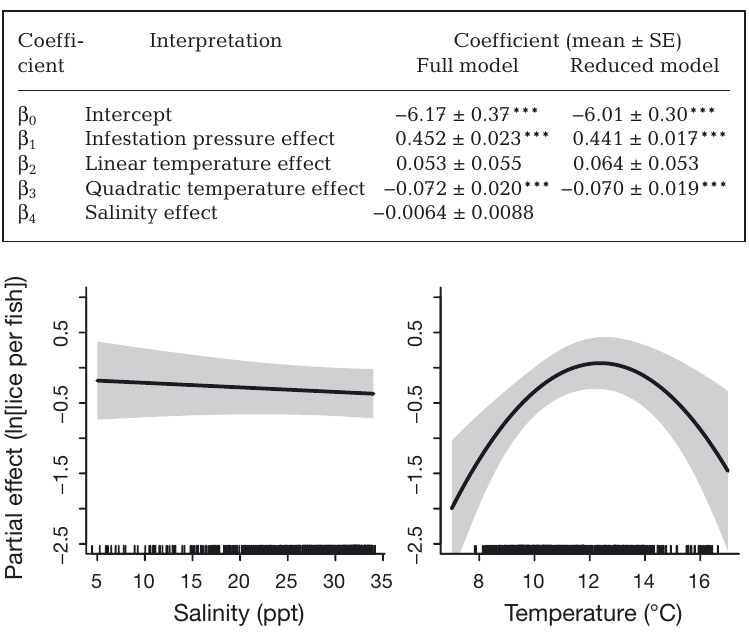
Fig. 6. Estimated additive effects of salinity and temperature on ln(lice per fish). The figure shows partial effects with 95% pointwise confidence